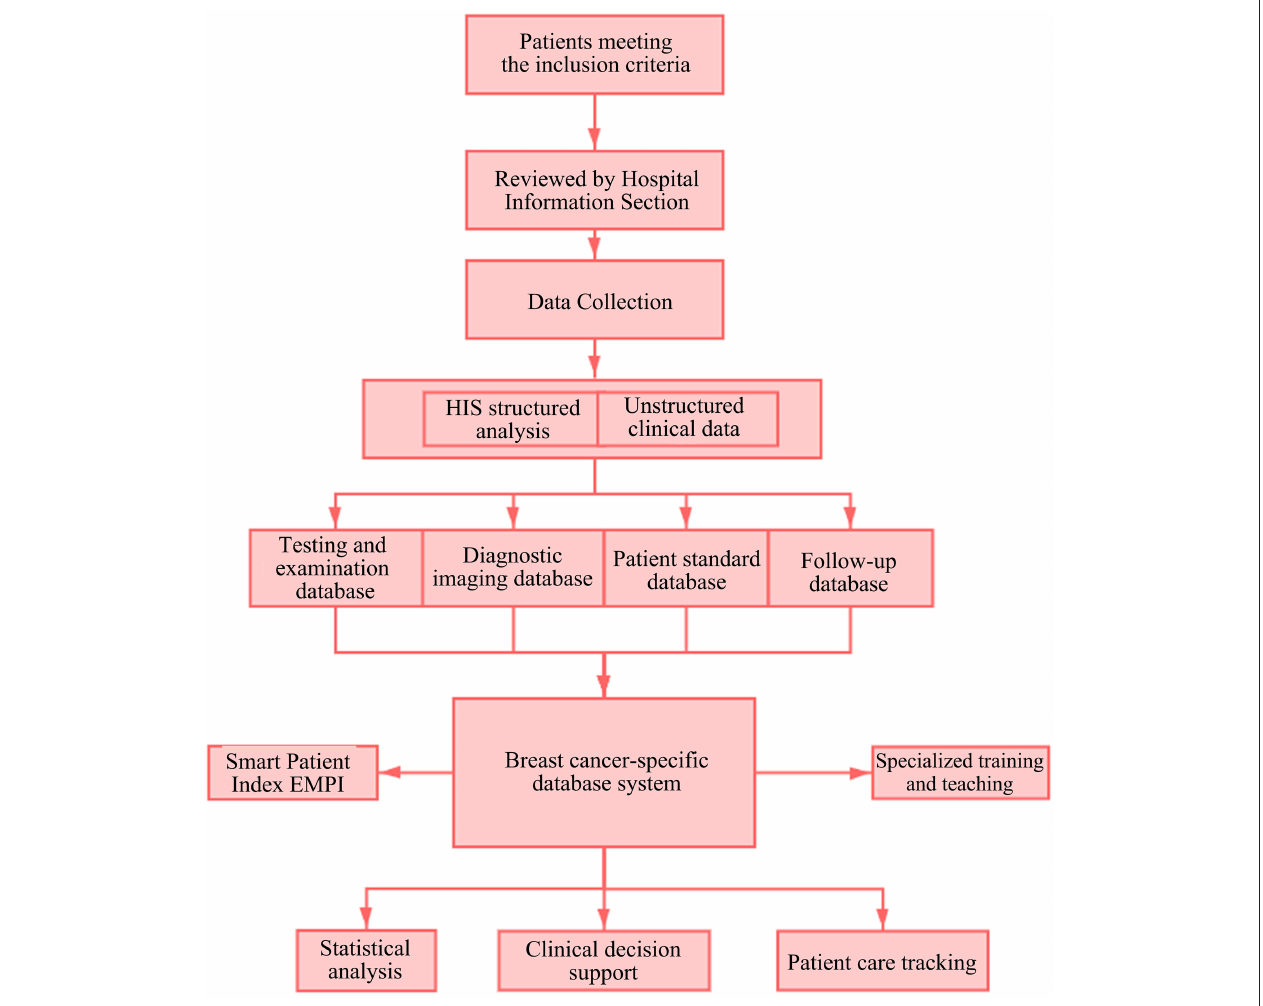
FIGURE 1 | Overall design of breast cancer-specific database system. HIS, Hospital Information System; EMPI, Enterprise Master Patient